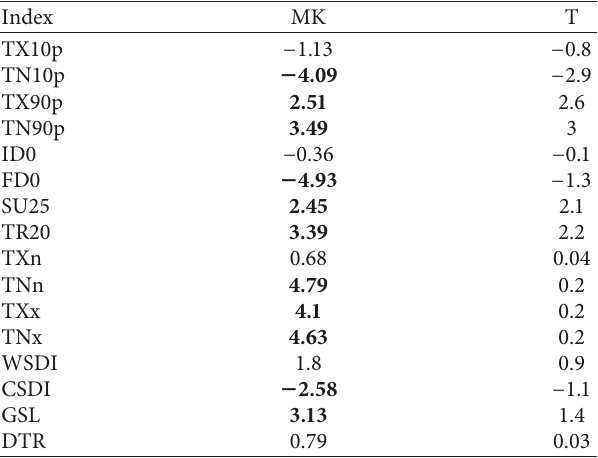
the Minjiang River